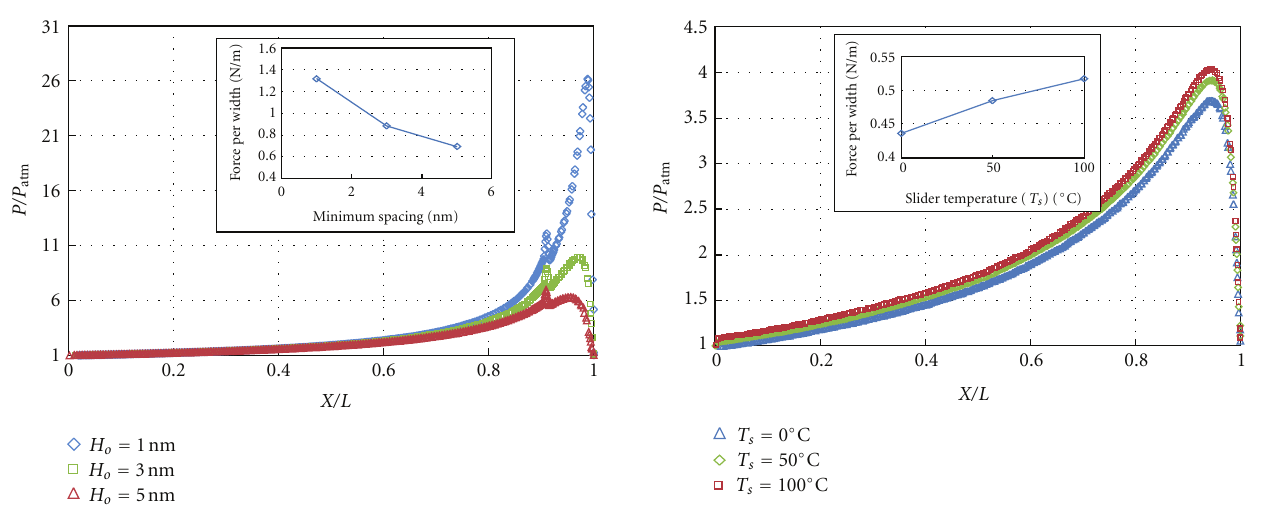
Figure 7: Comparison of air bearing pressure profiles on the slider surface with a 0.05 μ m heated spot on the disk for di ff erent minimum channel heights ( H o ) with a fixed pitch angle ( α ) of 0.01rad and (insert) the comparison of bearing forces at di ff erent minimum channel heights with a 0.05 μ m heated spot.